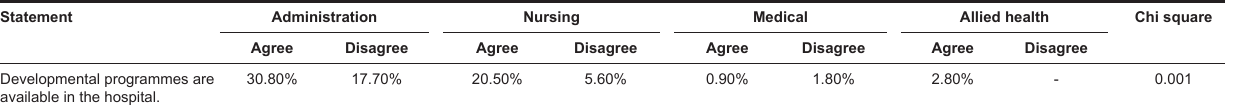
TABLE 3 Perceptions based on organisational